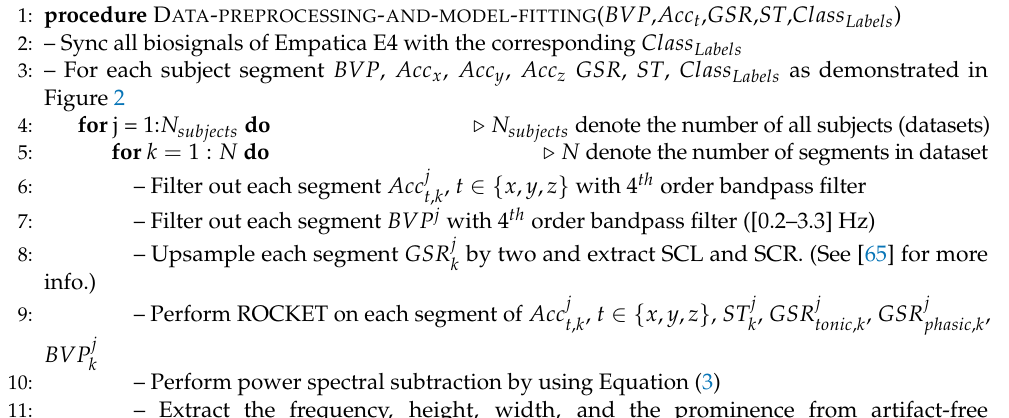
Algorithm 1 Pseudocode for training classifier models from raw